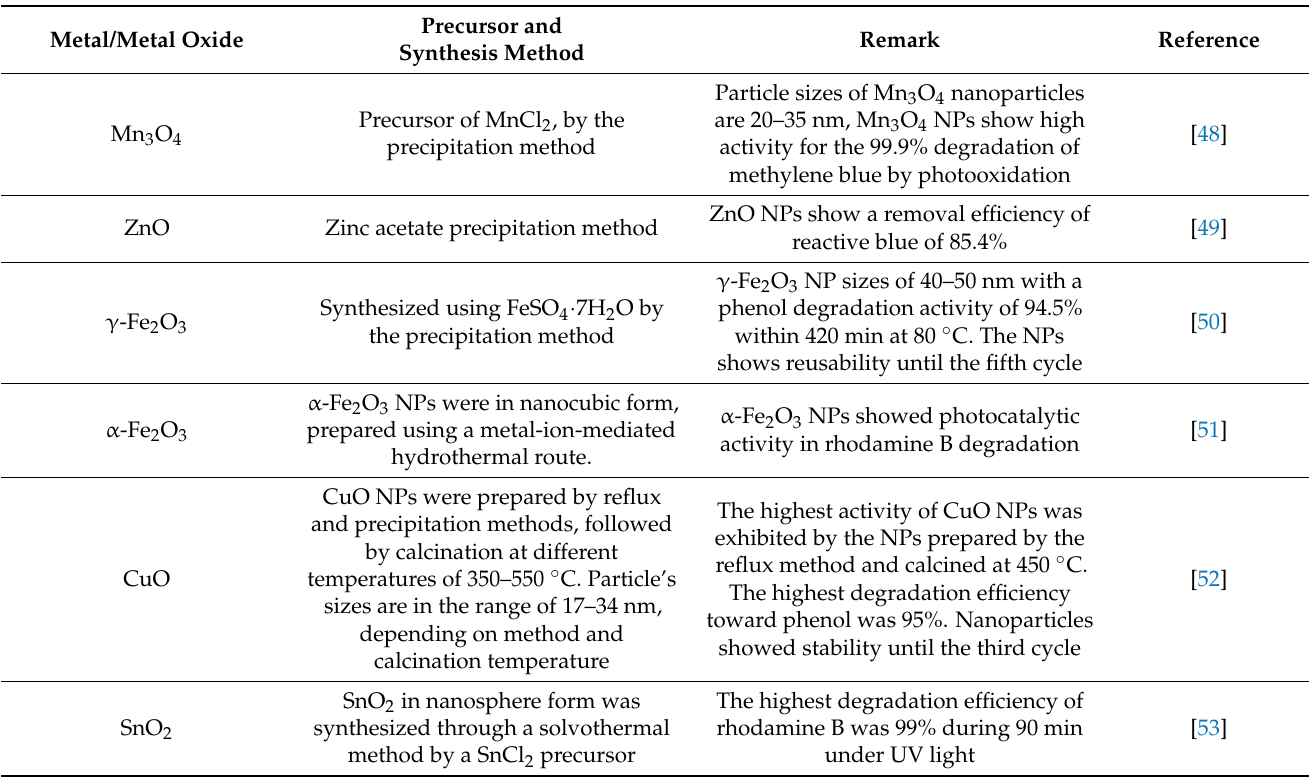
Table 1. Metal oxide nanoparticles for AOP